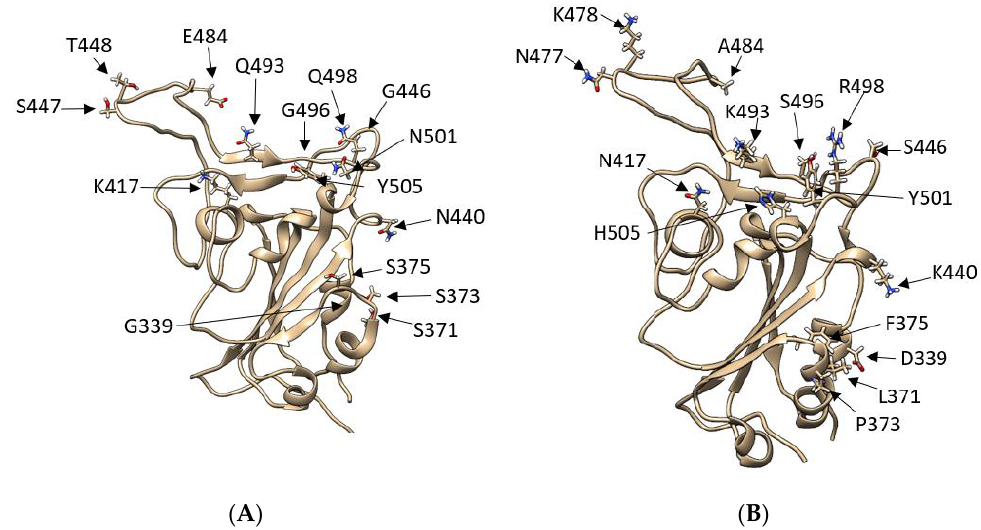
Figure 1. Comparison between SARS-CoV-2 RBD wild type and SARS-CoV-2 RBD Omicron: ( A ) SARS-2 WT RBD model showing residues T333-P527, with the original WT amino acids represented as liquorice. ( B ) SARS-2 WT RBD model showing residues T333-P527, with the Omicron mutations highlighted and represented as liquorice. With a total of 50 mutations, 15 of which are on the RBD, the Omicron variant possesses a different configuration of polar residues in the region between N477-H505 and a notable K417N mutation.